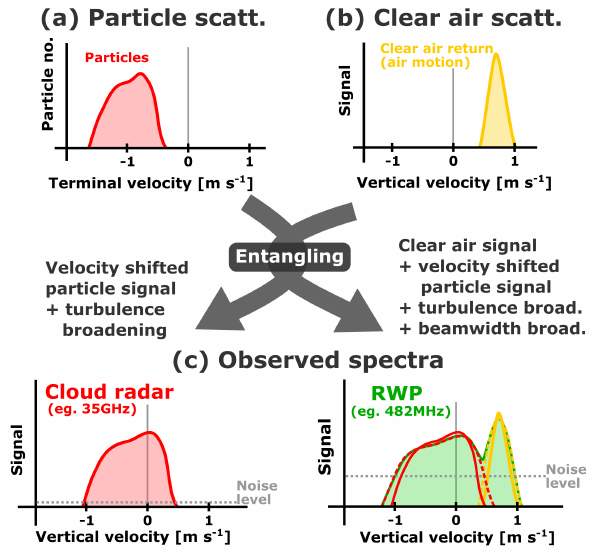
Figure 1. Scheme illustrating the contribution of particle and clear- air scattering to the Doppler spectra of the radars. Scattering from particles (and their terminal fall velocity relative to the surrounding air) and the clear-air return from the air motion are caused by com- pletely different processes and have to be considered separately in an ideal case (a) . Both processes are entangled when observed by real instruments (b)